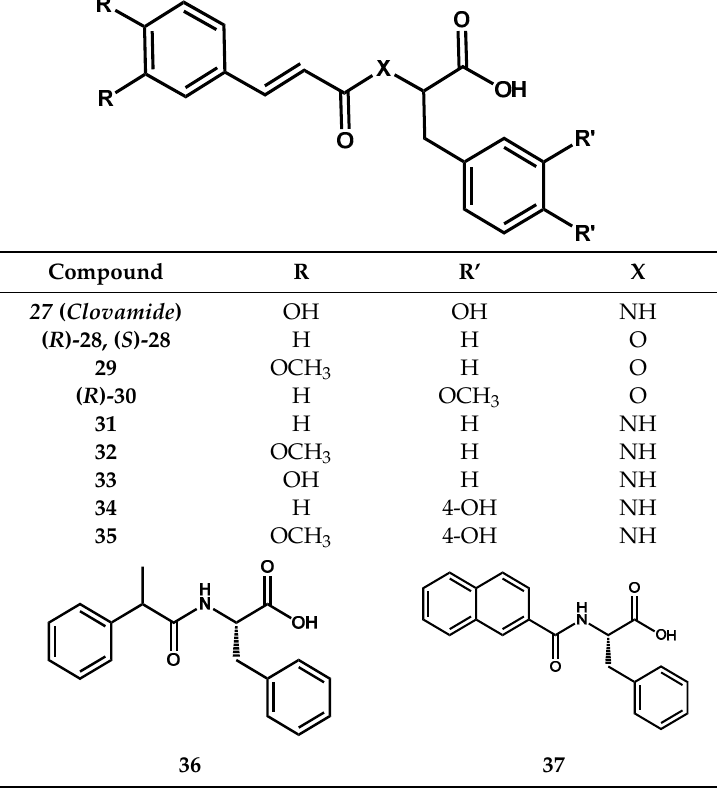
Table 3. Molecular structures of tested derivatives of rosmarinic acid.